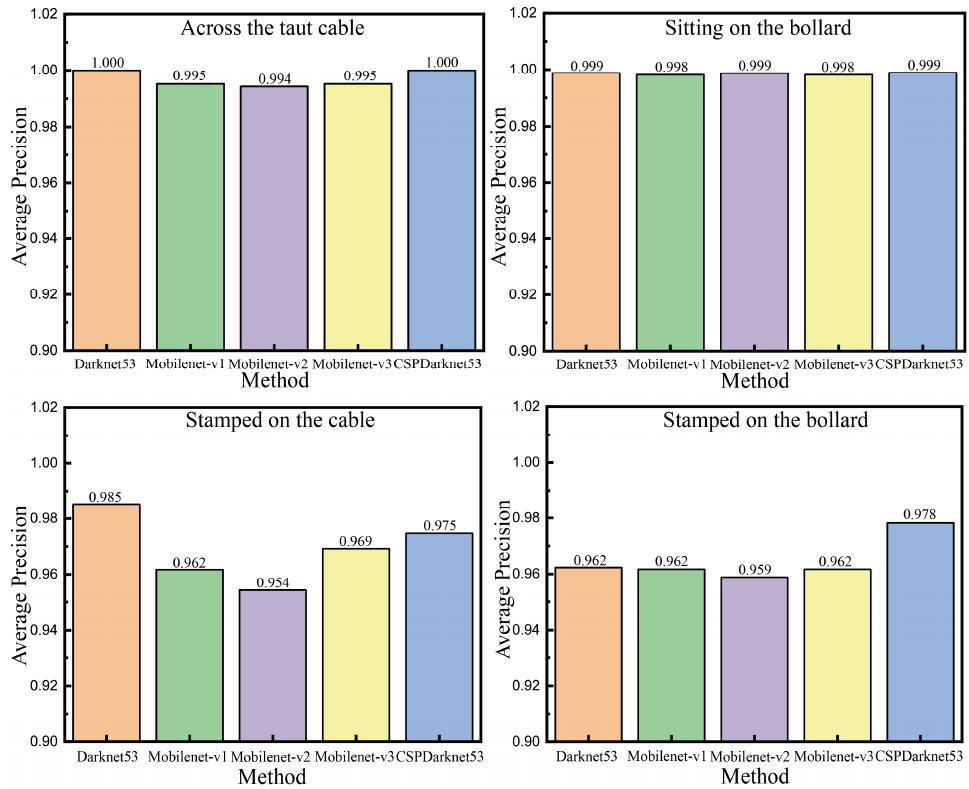
Figure 20. Comparison of the accuracy rates of several selected unsafe actions.